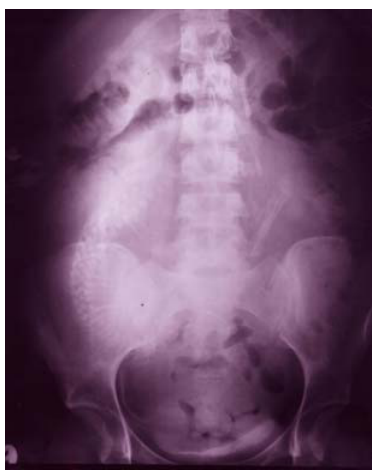
FIGURE 1b . Same patient, 2.5 hour film demonstrates near-total drainage of all contrast. Diagnosis: Symptomatic right hydronephrosis of pregnancy, moderate without evidence true obstruction. Pain resolved with bedrest in the left contralateral